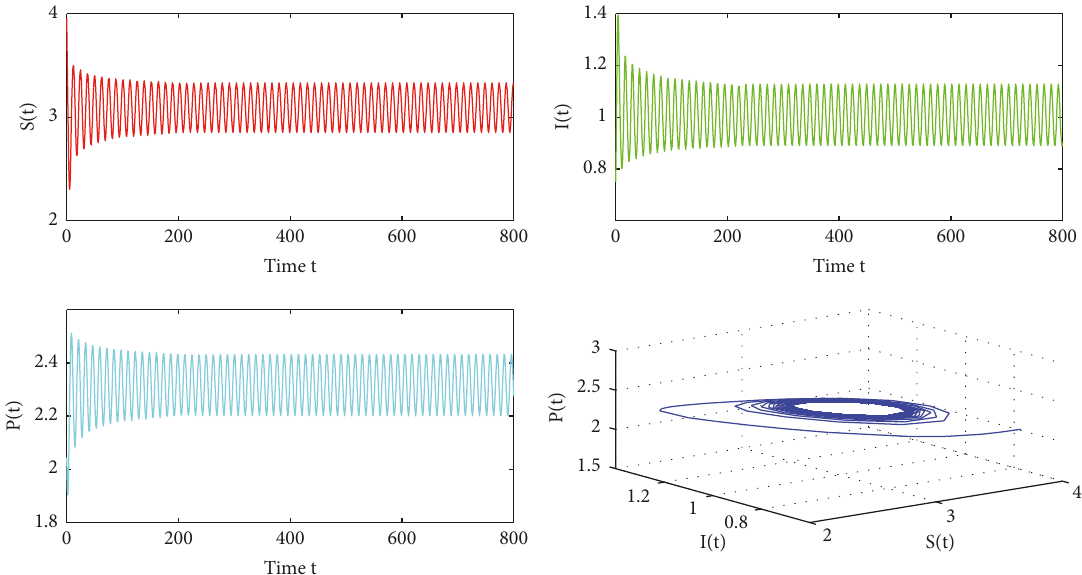
Figure 3: 𝐸 ∗ loses its stability when 𝜏 = 0.405 > 𝜏 0